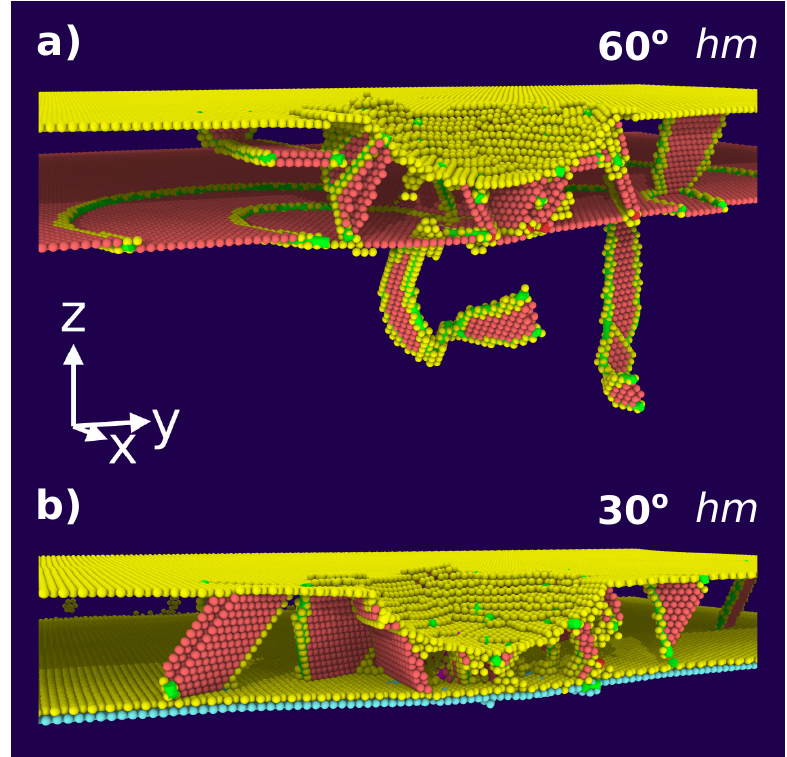
Figure 4. Dislocation network building up after indentation to a depth of 2.1 nm into a Ni bi-crystal containing a ( a ) 60 ◦ and ( b ) 30 ◦ grain boundary at 3 nm depth. Atoms are colored according to common-neighbor analysis. Red: stacking faults; yellow (cyan): defective atoms in the upper (lower) Ni grain. Fcc atoms have been removed for clarity. Green lines shows Shockley